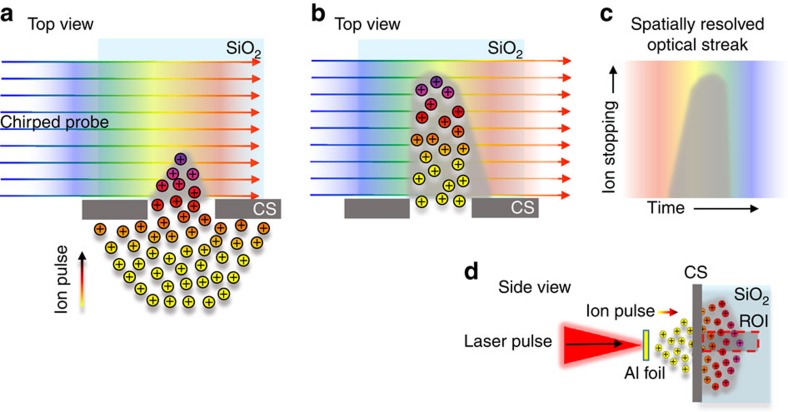
Schematic of the optical streaking technique for laser-driven proton bursts.Protons accelerated from a thin contamination layer on the rear surface of 10-μm-thick Au foils via the TNSA mechanism undergo electronic stopping in a high-purity SiO2 sample at ∼300 K placed 5 mm behind the interaction. The corresponding transient opacity (grey) is recorded using a synchronized 1,053-nm probe pulse with a variable linear frequency sweep, or chirp26. This permits observation of the interaction over time windows ranging from 0.4±0.02 (fully compressed pulse for direct imaging of interaction and represents the fundamental temporal resolution of this system) to ∼1,400 ps (maximum chirp for optical streaking). In a and b the proton bunch is incident from below and collimated to a width of 100 μm using a 1-mm-thick Al slit collimating slit (CS). Co-propagating keV electrons are stopped with the use of a 50-μm Al foil at the interaction facing surface of the SiO2 (not shown). A chirped pulse (>50 ps) is incident from the left. Different frequency components traverse the irradiated region at different times, thus encoding the temporal evolution in the observed spectrum. It is important to note that the bandwidth of the optical probe (4 nm) is narrow compared with the width of the absorption spectrum for conduction band electrons in SiO2. The optical streak is obtained by spectrally resolving the chirped pulse (c) using a 1-m imaging spectrometer with a 1,200 l mm−1 grating (dimensions 10 × 10 cm). The region of interest (ROI, (d)) for the ion burst interaction is a 10-μm scale slice along the central axis of the driving laser pulse. This is imaged onto the entrance slit of the spectrometer with a magnification of ∼10. The fundamental temporal resolution of the system described here is limited only by the resolution of the spectrometer26. For a 200-ps probe this system provides a resolution of 0.45±0.05 ps.